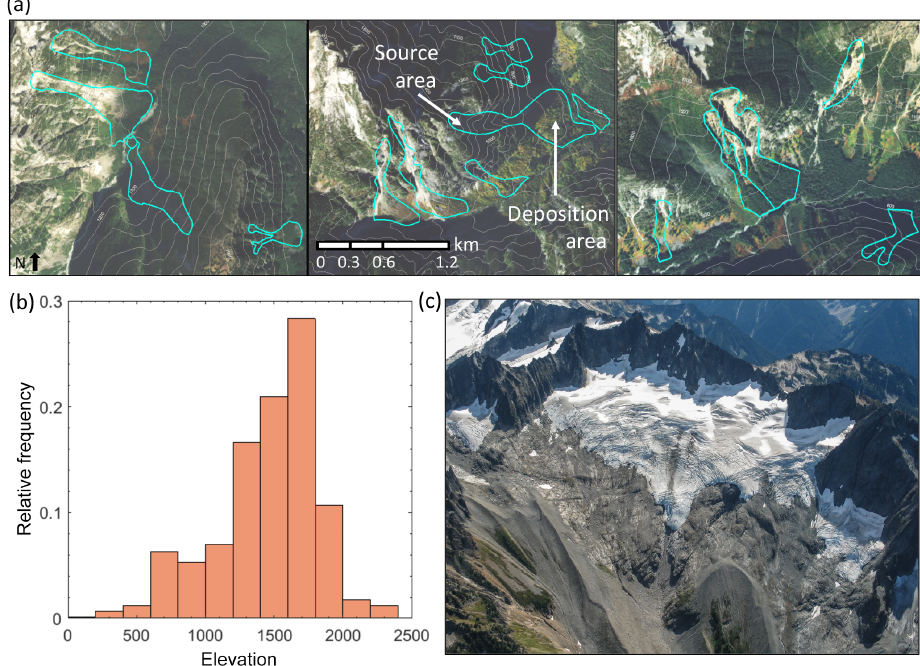
Figure 3. (a) Example debris avalanches (cyan) mapped in three areas within NOCA. Contours are in 100m intervals. Aerial images are from World Imagery, Esri Inc. (images created using ArcGIS ® software by Esri. ArcGIS ® and ArcMap ™ are the intellectual property of Esri and are used herein under license. Copyright Esri©. All rights reserved. For more information about Esri ® software, please visit www.esri.com.). (b) Elevation distribution of the relative frequency of mapped debris avalanche source areas (upper 10%). (c) High-elevation rock and glacier surrounding Spiral Glacier in the North Cascades showing a bedrock glacier cirque with thin barren soils and moraine deposits (photo by John Scurlock, used with